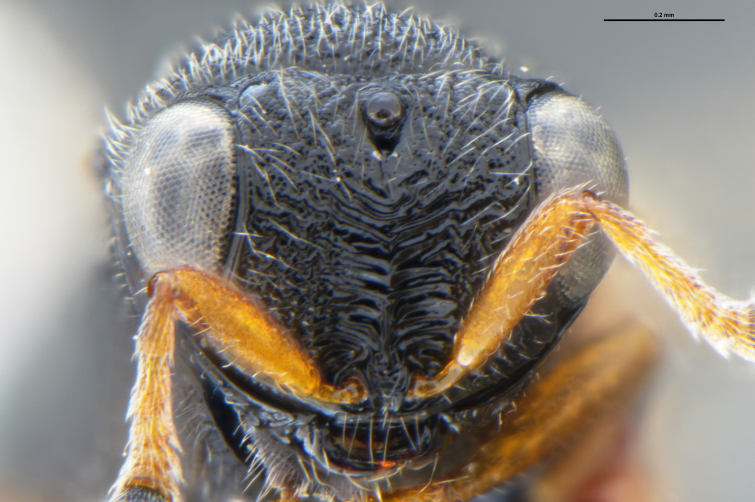
head, anterior view